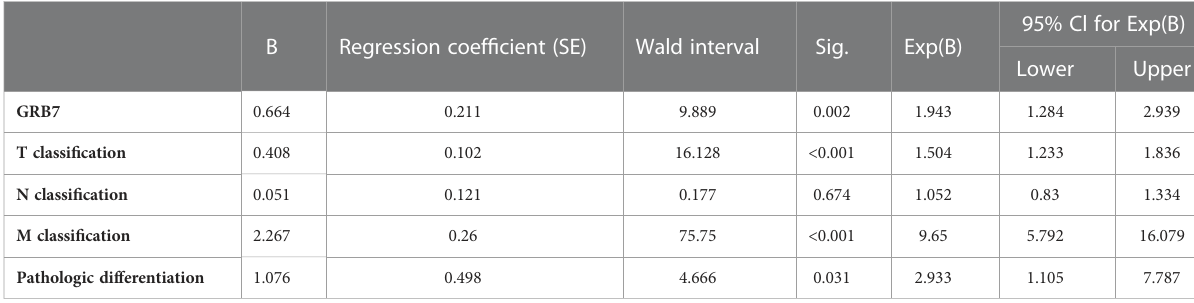
TABLE 2 Multivariate analyses of various prognostic parameters in patientswith gastric cancer Cox-regression analysis.